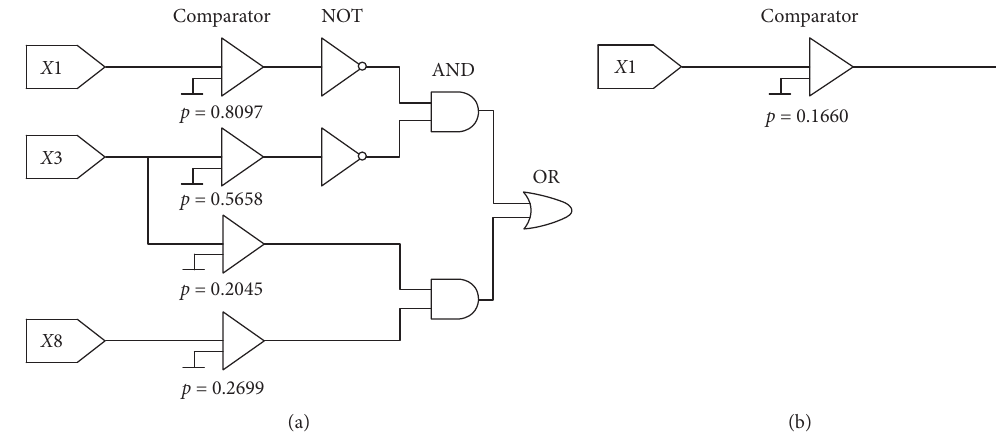
Figure 10: Logical circuit classifiers of GID and CVRD problems.